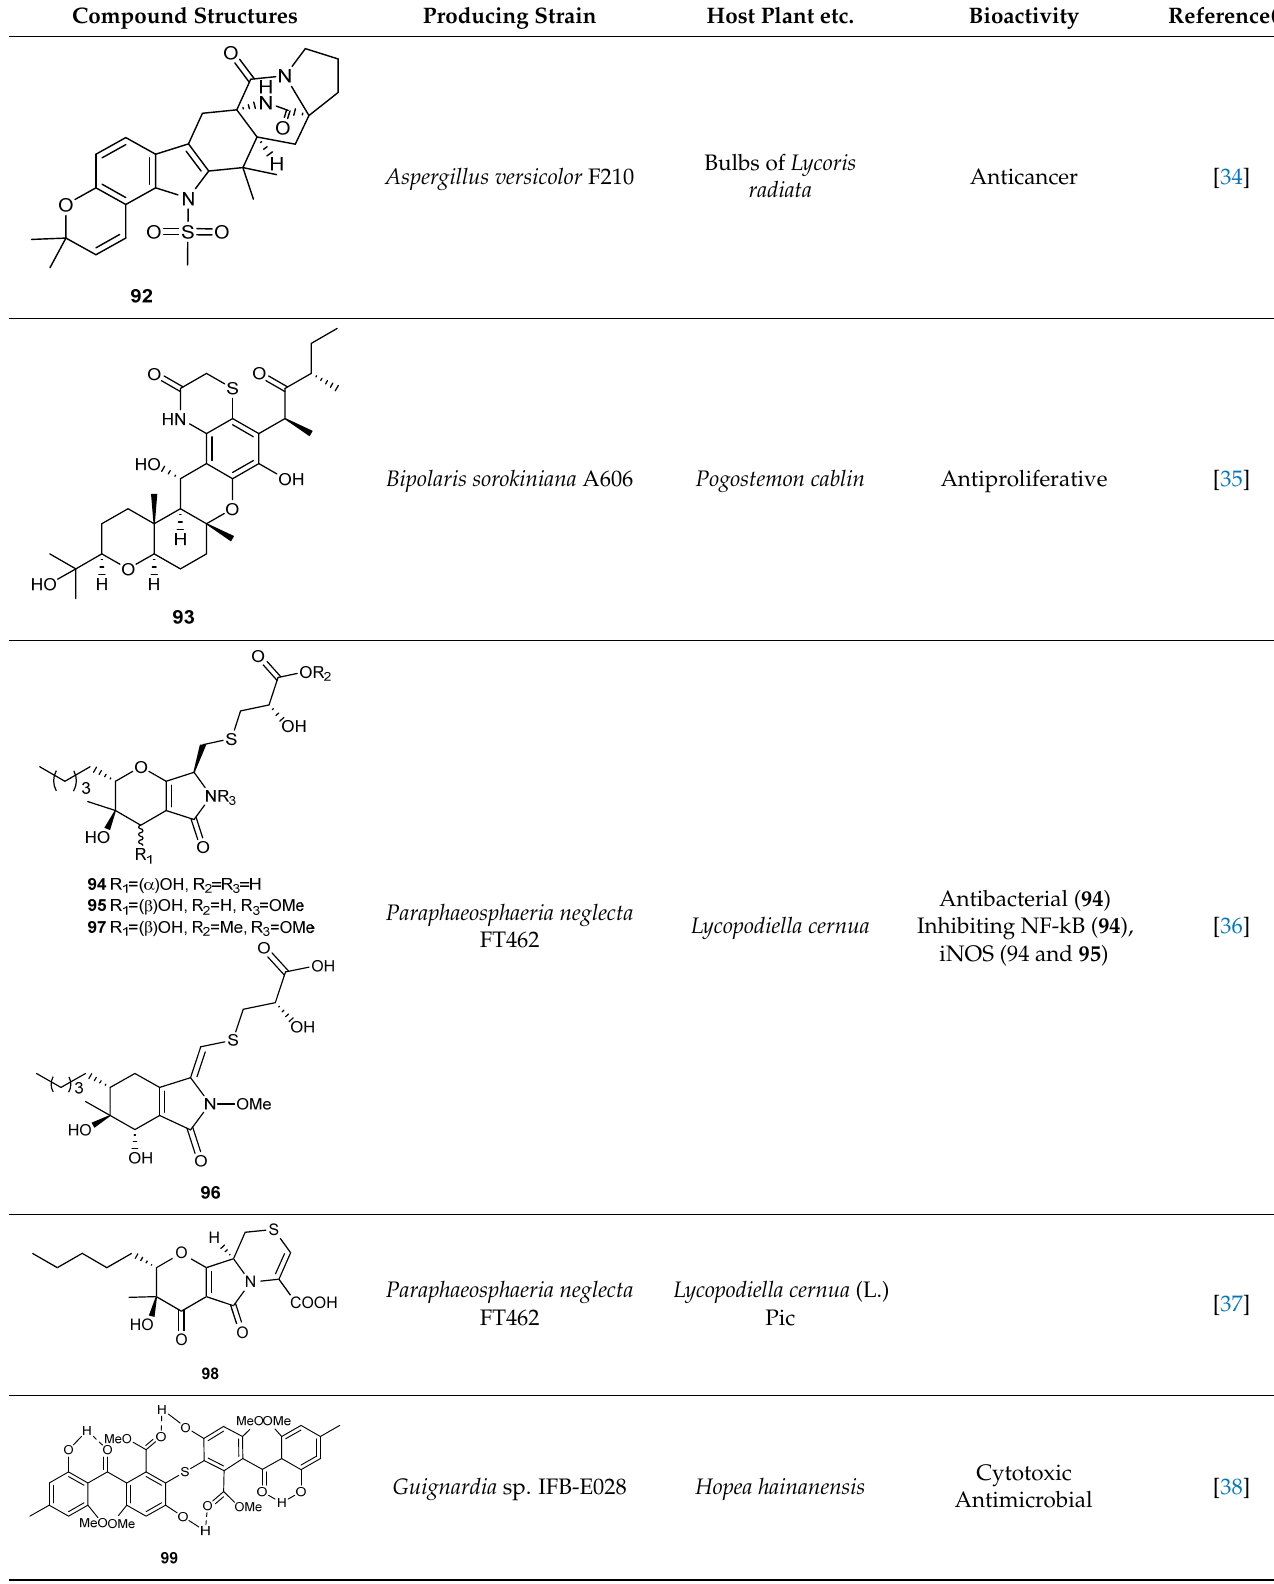
Table 1. Cont . Compound Structures Producing Strain Host Plant